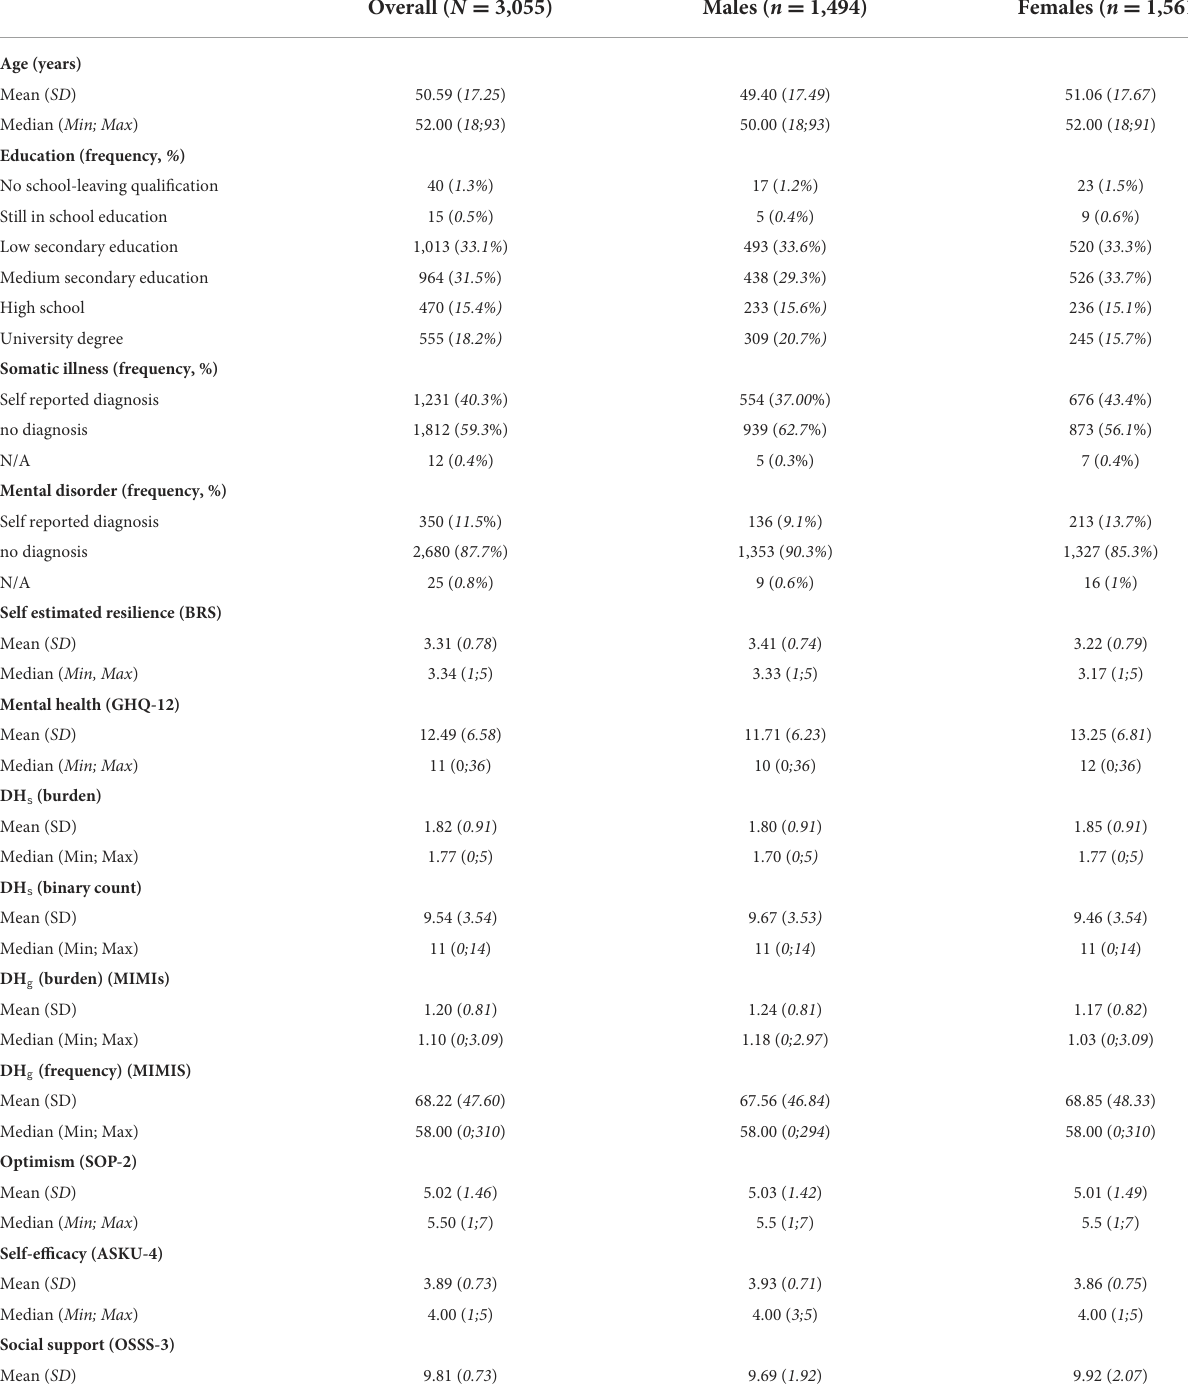
TABLE 1 Demographic characteristics of the